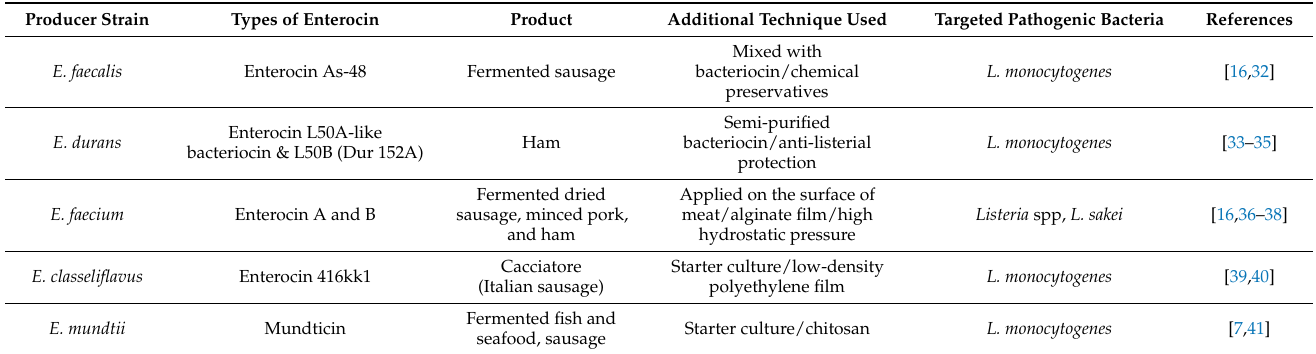
Table 3. The types of enterocin produced by Enterococcus sp. used in raw meat